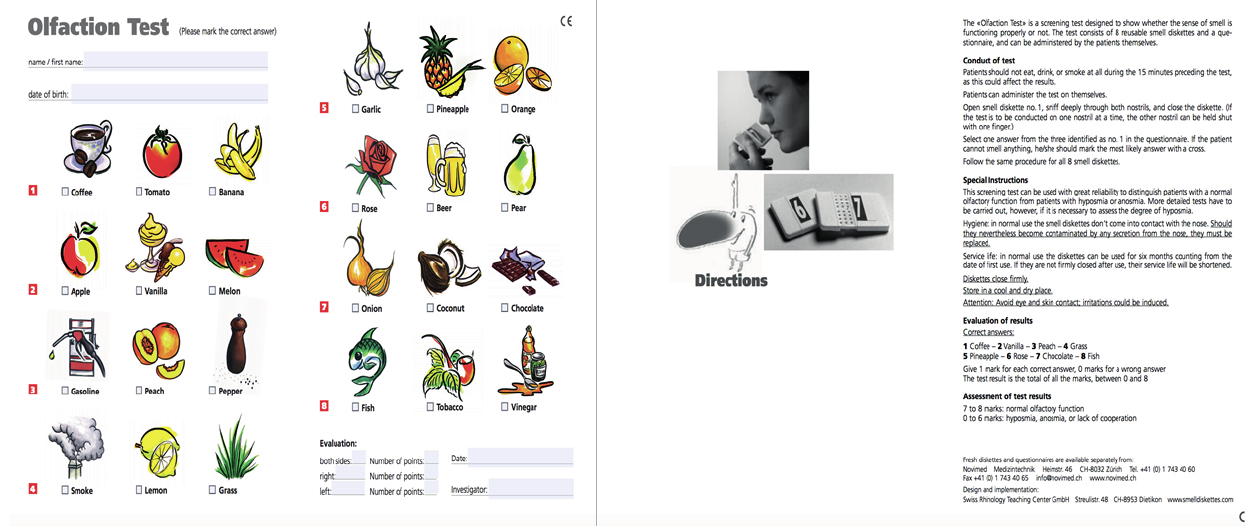
Figure 1. Original "Smell Diskettes"